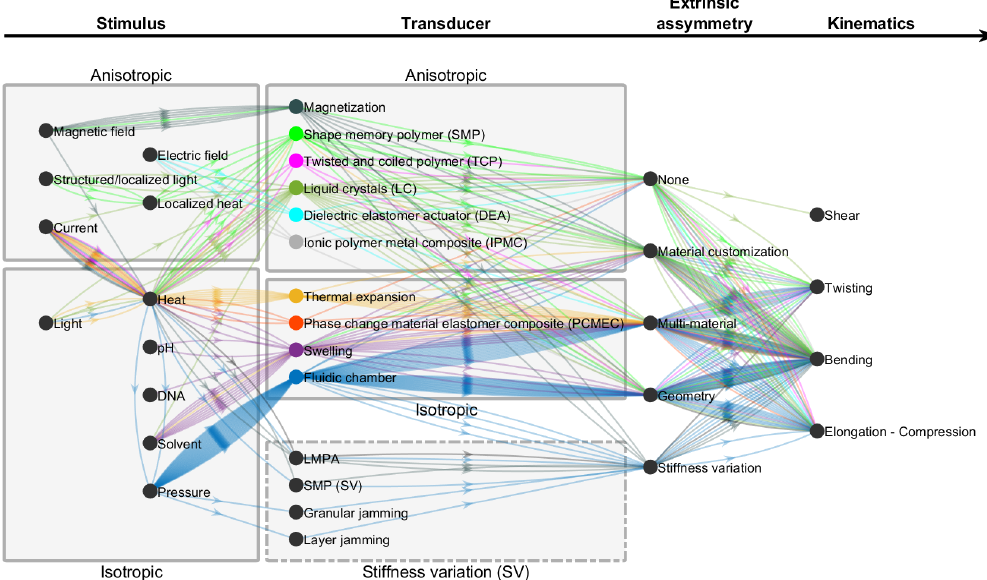
Figure 2. Roadmap of actuator design from stimulus to actuation: each actuator reviewed is represented by a set of arrows. The arrow colors indicate the main transducer principle used to generate a deformation. Actuators using several stimuli, transducers, or extrinsic asymmetry or are able to generate several kinematics are represented by several